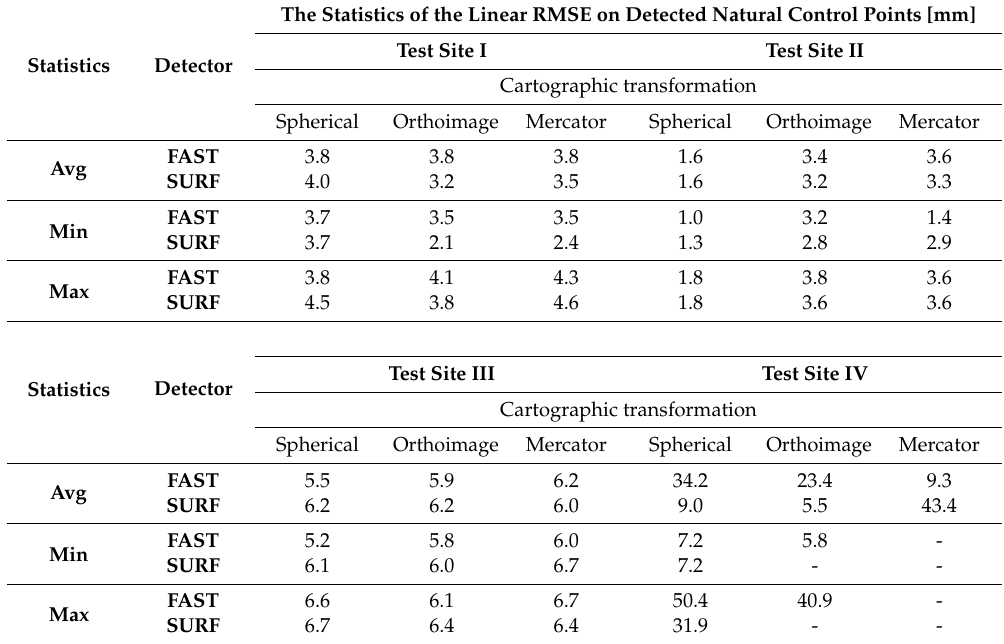
Table 9. The statistics of the RMSE values on natural control points for all test sites (both